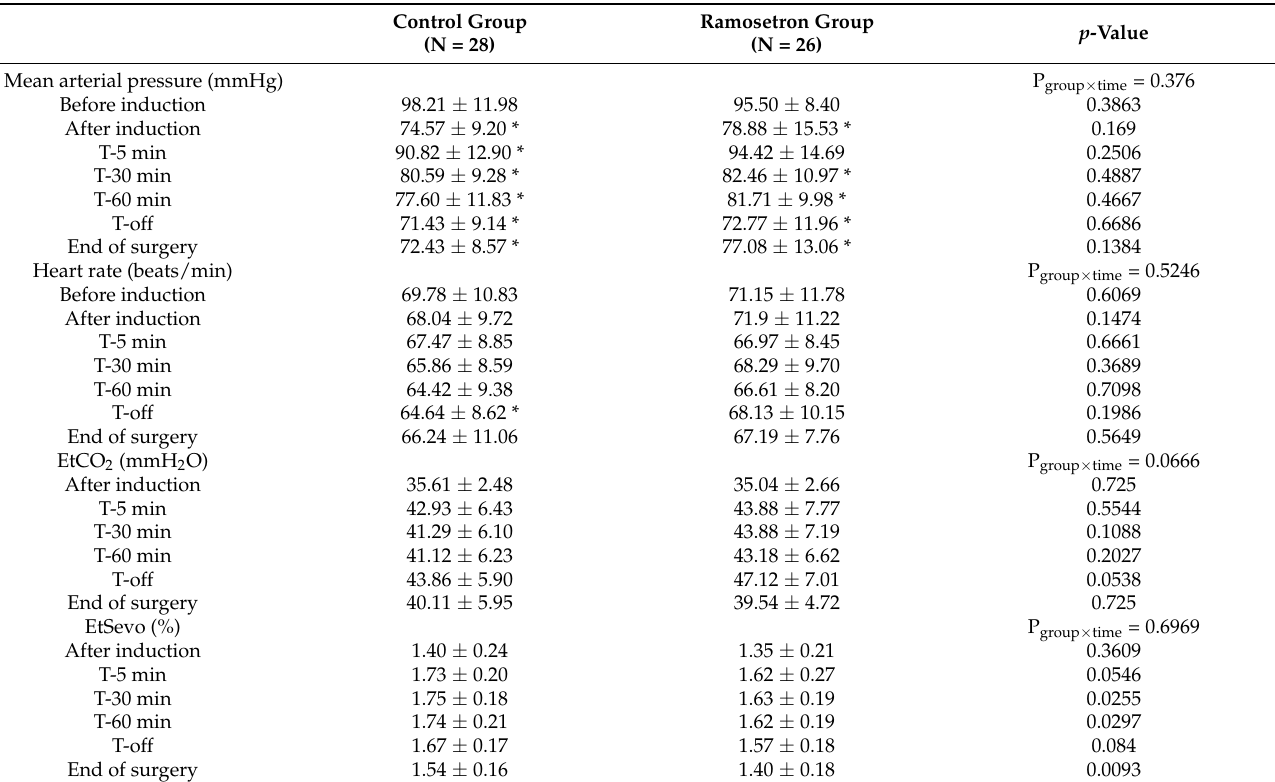
Table 3. Hemodynamic profiles and intraoperative variables during robot-assisted laparoscopic